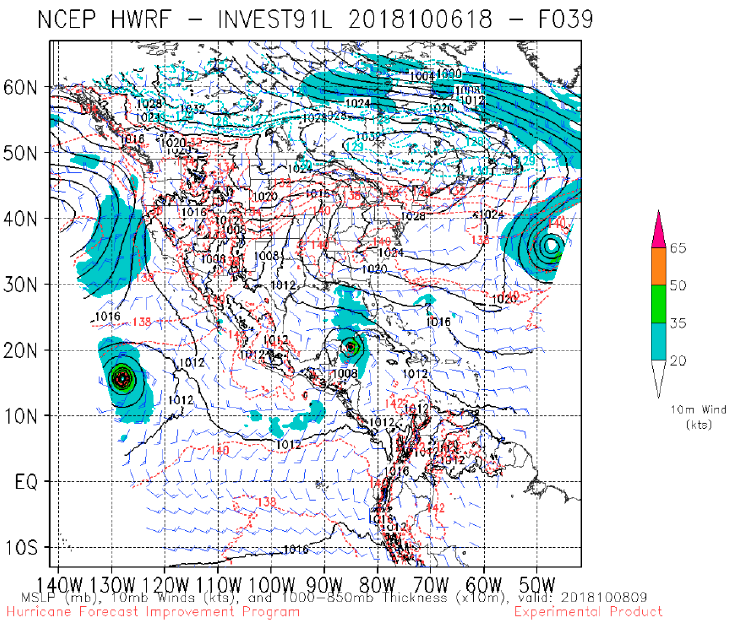
Figure 1. The outermost domain for a Hurricane Weather Research and Forecasting (HWRF) forecast of Hurricane Michael initialized at 1800 UTC on 06 October 2018. (courtesy of EMC).